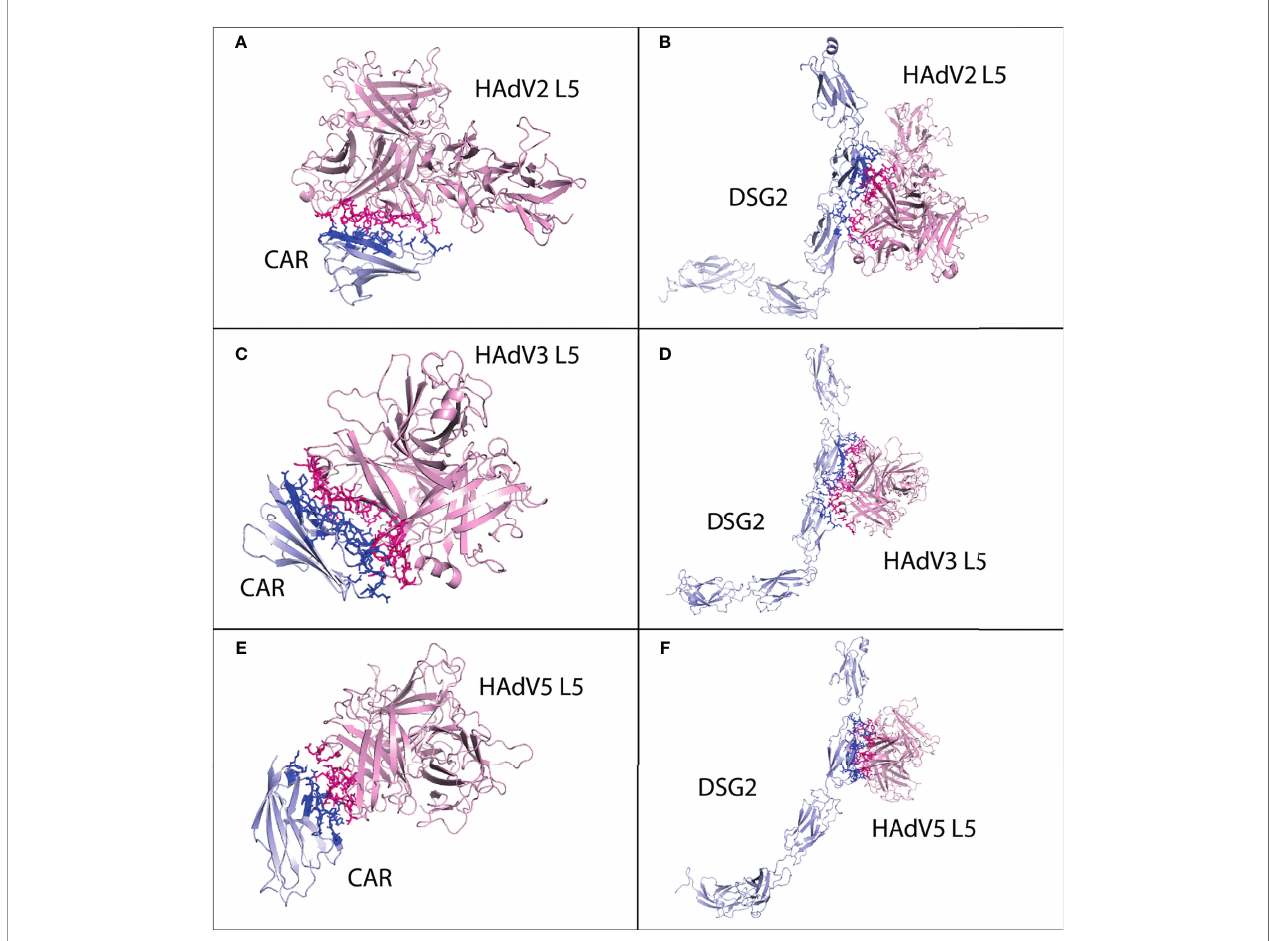
FIGURE 3 | Protein – protein interaction complex of HAdV2, HAdV3, and HAdV5 L5 protein with human CAR, DSG2, and CR1 receptors. (A) CAR made a total of 63 interactions with HAdV2 L5 protein. (B) DSG2 made 86 interactions with HAdV2 L5 protein. (C) CAR made 107 interactions with HAdV3 L5 protein. (D) DSG2 made 110 interactions with HAdV3 L5 protein. (E) CAR made 59 interactions with HAdV5 L5 protein. (F) DSG2 made 89 interactions with HAdV5 L5